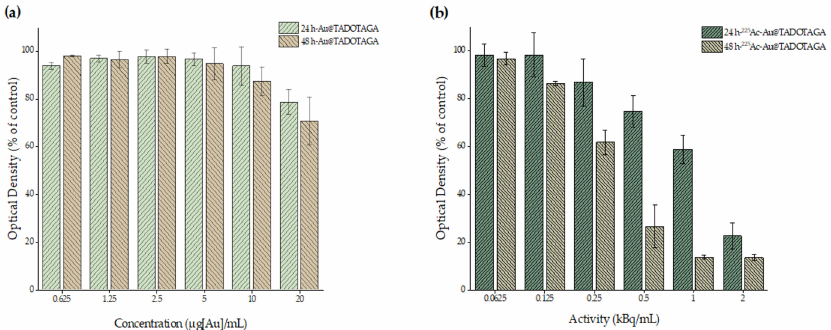
Figure 2. In vitro cytotoxicity of Au@TADOTAGA ( a ) and [ 225 Ac] 225 Ac-Au@TADOTAGA ( b ) in U-87 MG cells by MTT assay. Data are presented as mean ± SD ( n = 3 for a and n = 2 for b ). 3.5. Ex Vivo Biodistribution Studies: Intravenous vs. Intratumoral Injection